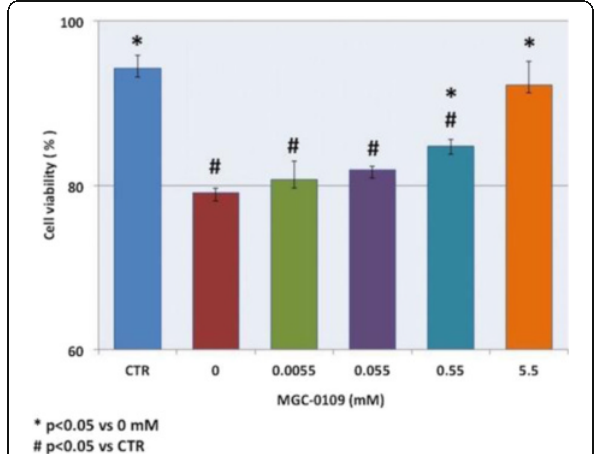
Fig. 86 (abstract A198). Cell viability following I/R injury. # p < 0.05 vs CTR (no I/R) and *p < 0.05 vs 0 mM (I/R,